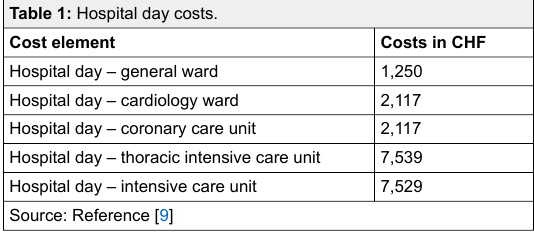
Table 2: Costs of investigations.